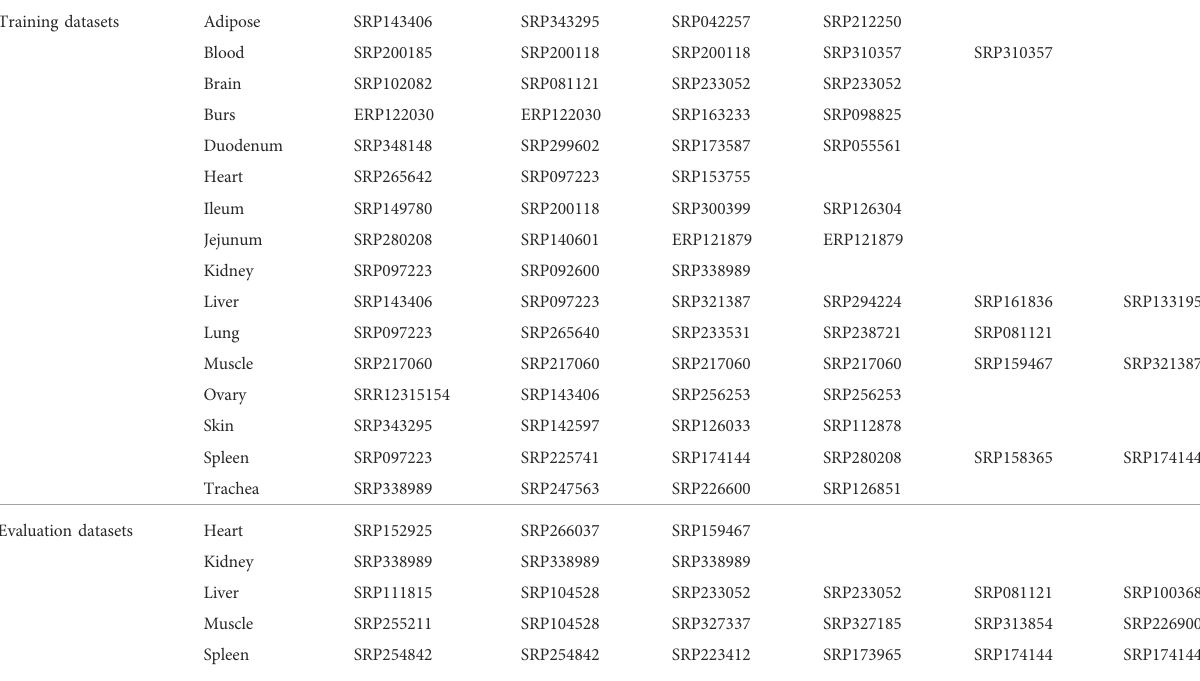
TABLE 1 Accession numbers of the used datasets for discovering the most stably expressed genes for 16 chicken